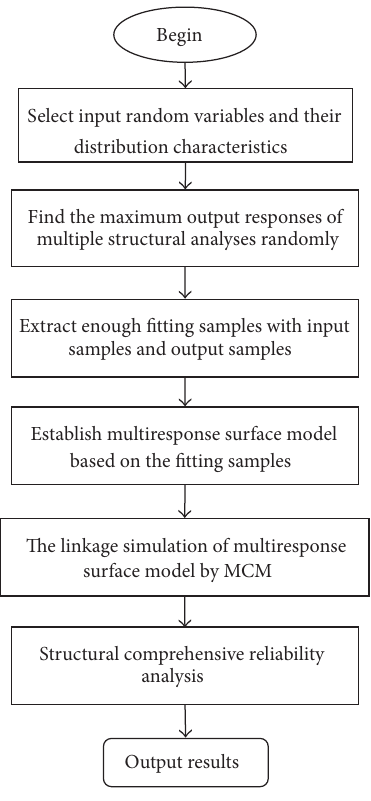
Figure 1: Flow chart of structural reliability analysis based on